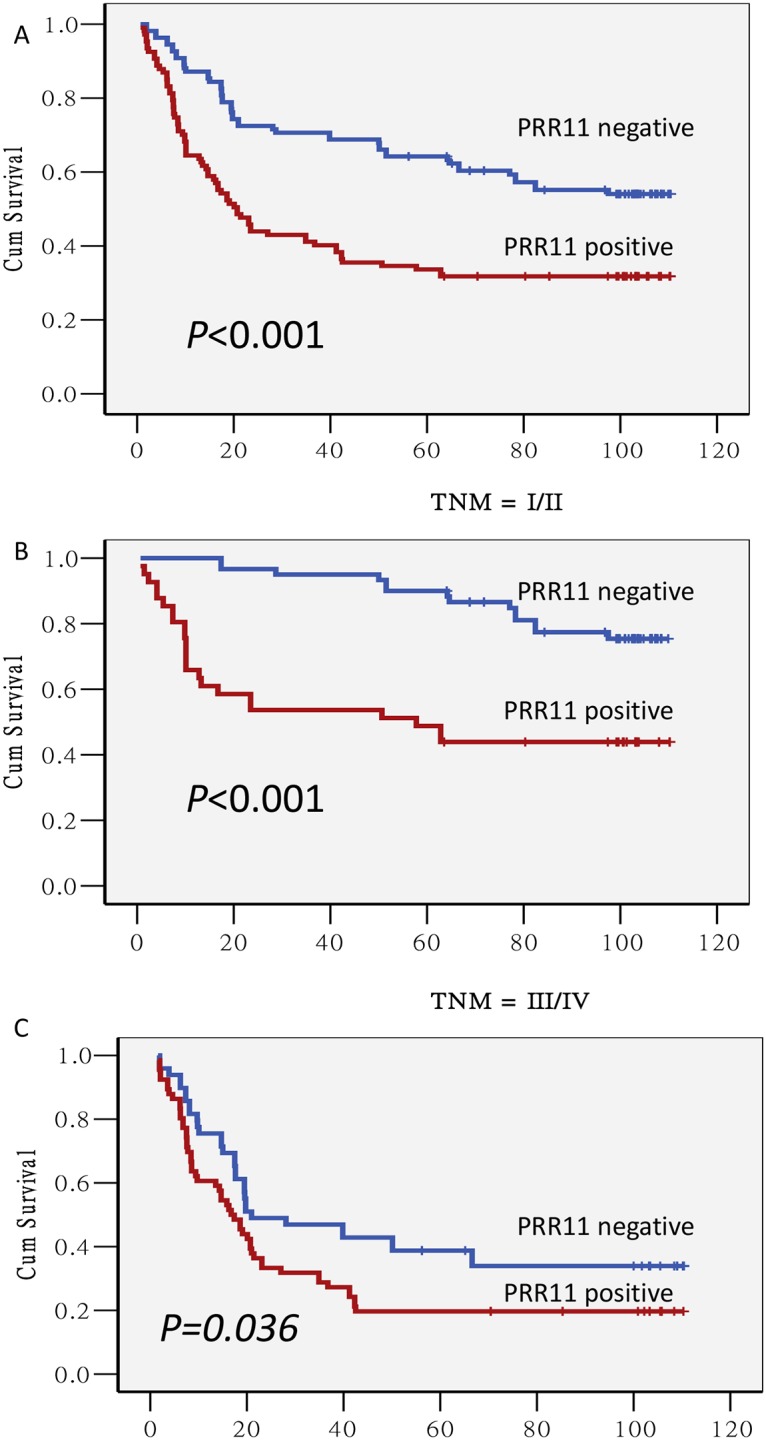
Kaplan-Meier survival curves of gastric carcinoma patients with and without tumor expression of PRR11.(A) Survival was significantly longer in patients with tumor lacking expression of PRR11 (OS, 76.6 month) versus those with positive PRR11 expression status (OS, 46.6 month; P < 0.001). (B) A subgroup analysis of stage I & II patients revealed that patients with a positive PRR11 expression status was associated with a shorter survival duration than patients without PRR11 expression (58.5mon vs. 97.9mon; P<0.001). (C) A subgroup analysis of stage III & IV patients demonstrated that positive PRR11 overexpression was associated with a shorter overall survival than patients without PRR11 expression (34.3mon vs. 51.3mon; P = 0.036).